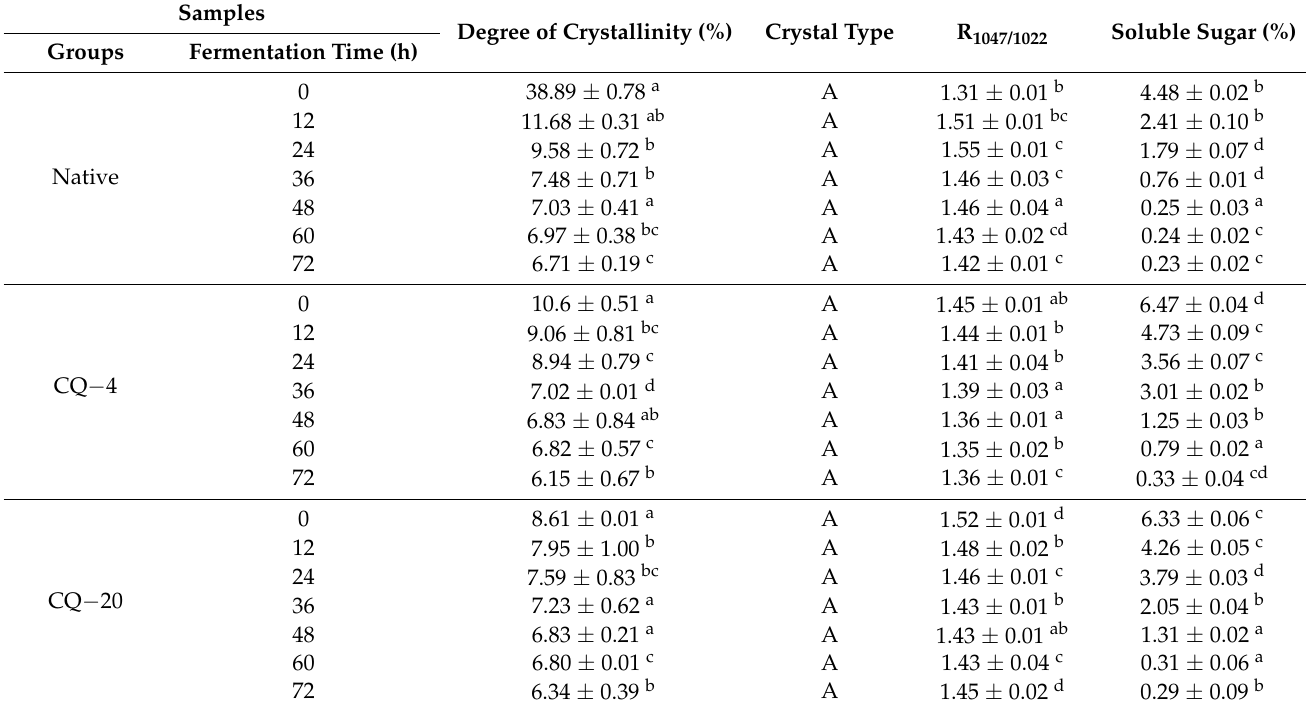
Table 1. The XRD patterns, FTIR intensity ratio and soluble sugar of native and fermented quinoa flour after cold